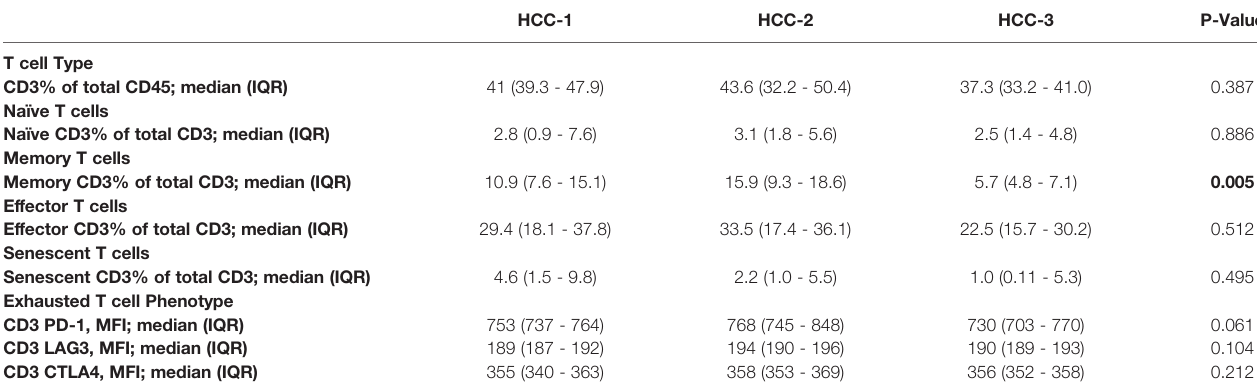
TABLE 6 | Peripheral T cell phenotypes prior to liver transplant by